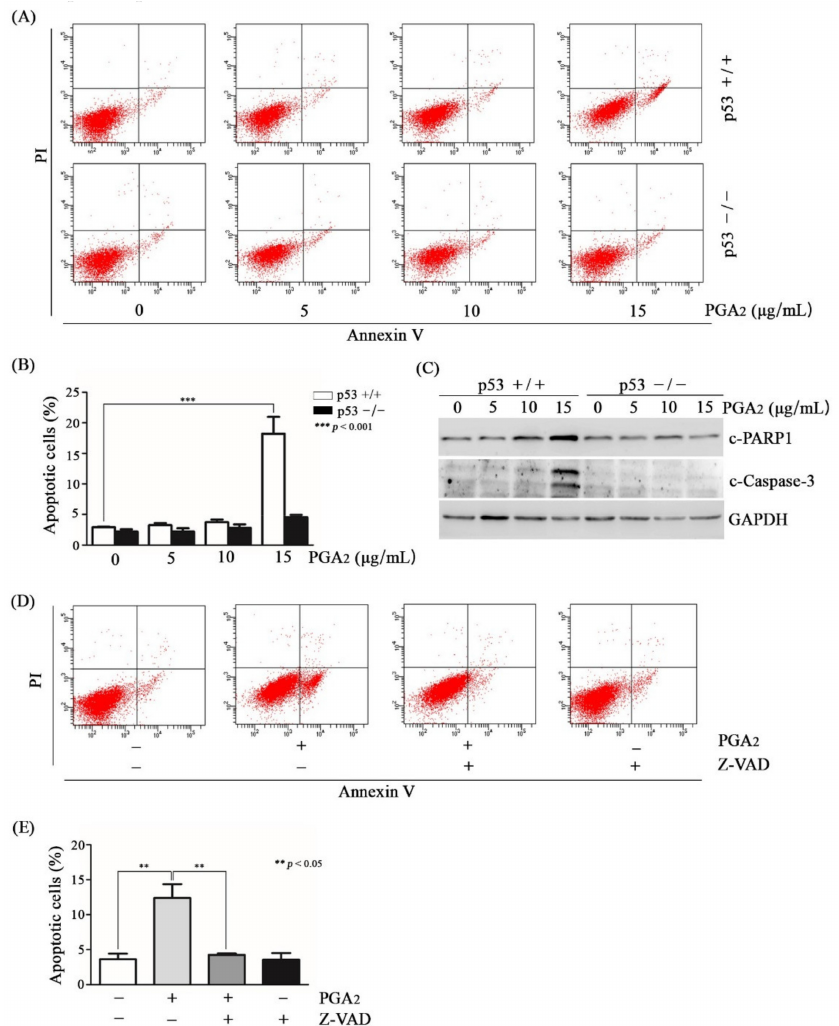
Figure 1. Comparison of PGA 2 -induced apoptosis between HCT116 cells (p53 +/+ ) and HCT116 p53 null cells (p53 - / -). ( A ) Cells were seeded at a density of 4 x 10 5 cells / well and treated with indicated concentrations of PGA 2 the next day. After 12 h post-treatment, cells were stained with annexin V and propidium iodide, which were subjected to flow cytometric analysis. The result is representative of three independent experiments. ( B ) The result of three independent annexin V assay performed in ( A ) was presented as mean ± standard error of the mean (SEM). ( C ) Whole cell lysates (WCL) of two cell lines treated the same as described in ( A ) were subjected to immunoblot analysis against cleaved PARP1 (c-PARP1), cleaved caspase-3 (c-Caspase-3), and glyceraldehyde-3-phosphate dehydrogenase (GAPDH) which was used as an internal reference protein for normalization. ( D ) HCT116 cells were pretreated with z-VAD-Fmk for 1 h and treated with PGA 2 (15 µ g / mL) for another 12 h. Cells were then subjected to annexin V assay. The result is representative of three independent experiments. ( E ) The result of three independent annexin V assay performed in ( D ) was presented as mean ±